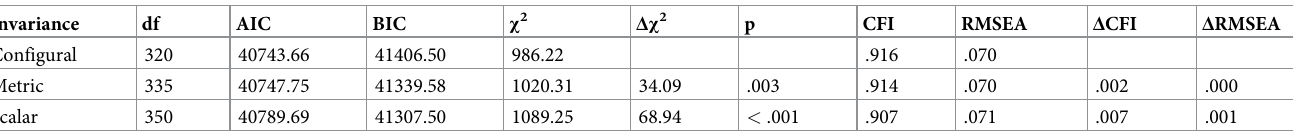
Table 1. Comparing configural, metric and scalar invariance across